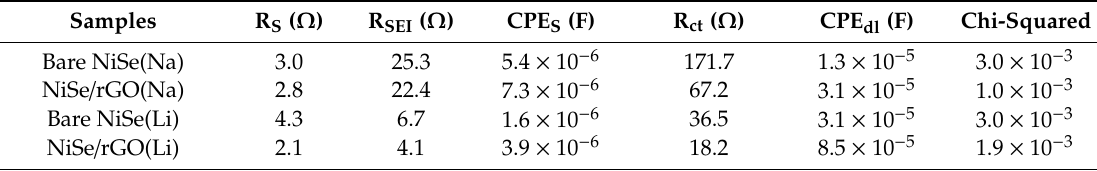
Figure 7. Electrochemical impedance spectroscopy (EIS) for the NIBs ( a ) and Li-ion batteries (LIBs) ( b ) with NiSe / rGO and bare NiSe electrodes after 10 cycles at a constant current density of 0.05 A g − 1 ; ( c ) equivalent circuit model of the EIS spectra. Table 1. Fitting results of the Nyquist plots using the equivalent circuit.